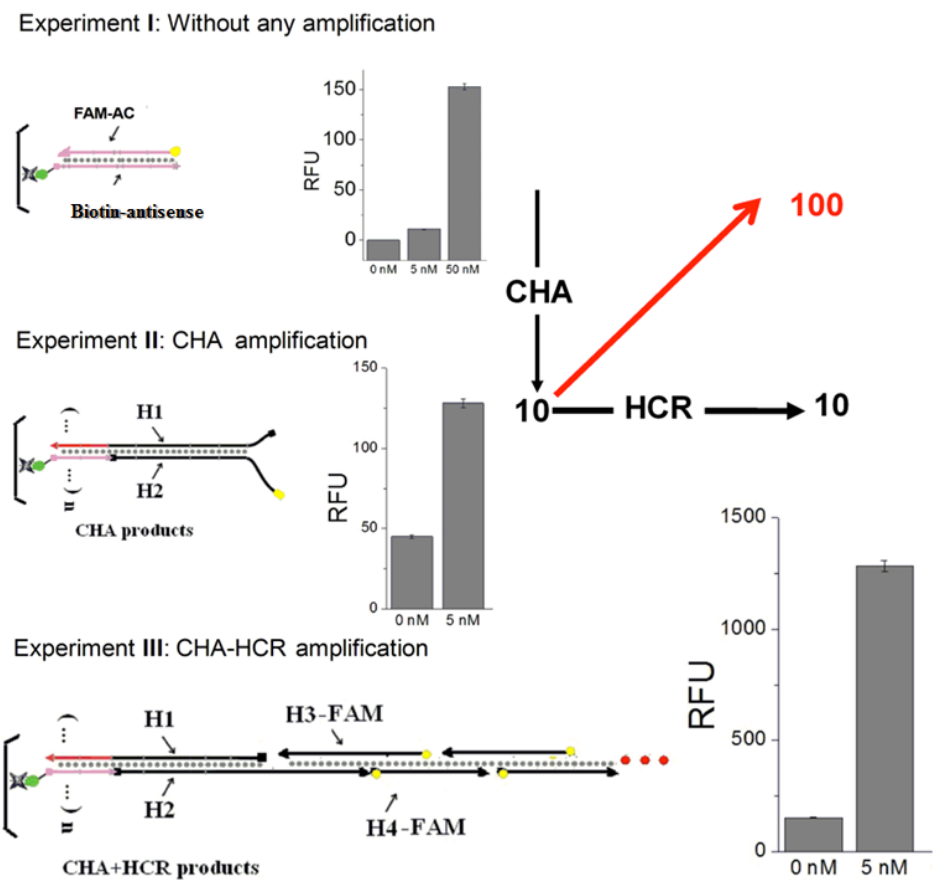
Figure 3. Confirmation of the two-layer amplifier. Experiment I: Without any amplification. Experiment II: With only CHA amplifier. Experiment III: With the standard CHA-HCR amplifier. The RFU in each bar graph is the mean of the steady-state data points collected during fluorescence kinetic